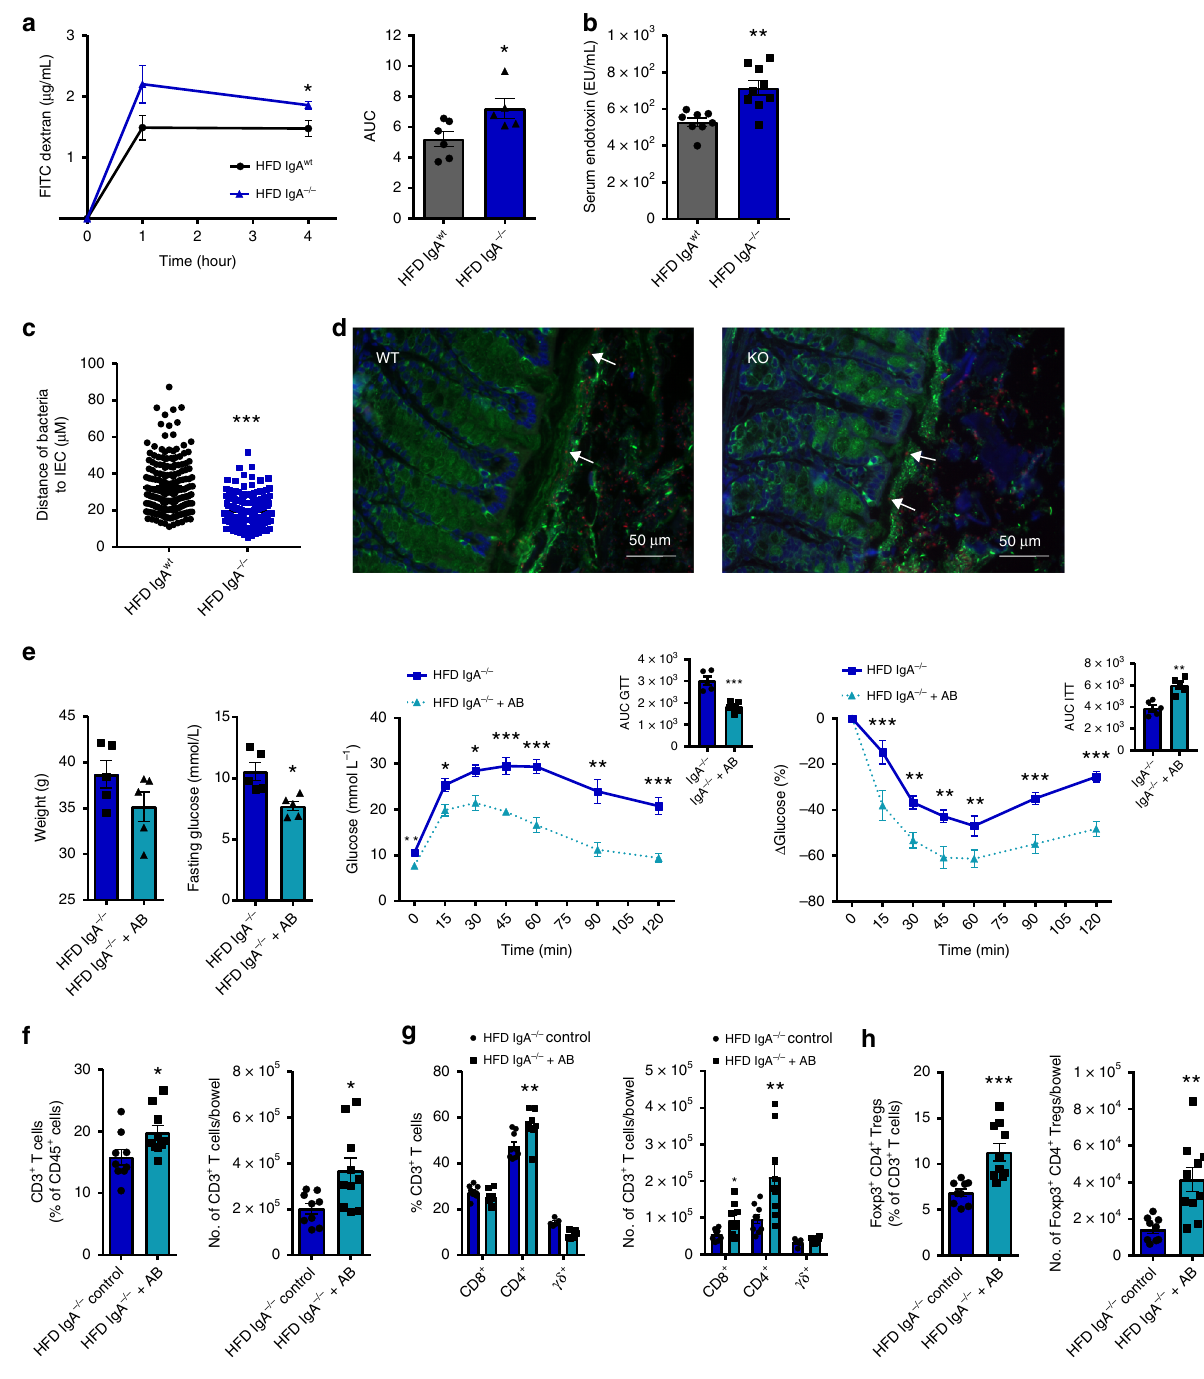
Fig. 6 Altered glucose metabolism in high fat diet (HFD)-fed immunoglobulin A (IgA)-de fi cient mice is linked to host – microbe interactions. a Intestinal permeability assay measuring concentration of fl uorescein isothiocyanate (FITC)-labelled-dextran by fl uorescence (left) and represented by area under the curve (AUC) (right) in collected plasma 1 and 4 h post gavage in HFD-fed wild-type (WT) and IgA − / − mice ( n = 6 WT, 5 IgA − / − mice). b Serum endotoxin levels in WT and IgA − / − mice fed HFD for 14 weeks ( n = 8 WT, 9 IgA − / − mice). c Distance of bacteria from intestinal epithelial cells (IECs) in HFD-fed WT and IgA − / − mice ( n = 4/group). d Representative images of fl uorescence in situ hybridization (FISH) and immuno fl uorescence staining of the bacteria (red), mucous layer (green), and intestinal cells (4 ′ ,6-diamidino-2-phenylindole (DAPI)-blue) of colon (scale bar = 50 µ m; white arrows indicate representative encroaching bacteria to intestinal epithelium). e Weights (left), fasting glucose levels (left middle), blood glucose concentrations with AUCs during glucose tolerance (GTT) (right middle) and insulin tolerance test (ITT) (right) in HFD-fed IgA − / − mice treated with antibiotics in drinking water for 4 weeks compared to HFD-fed IgA − / − untreated controls ( n = 5 mice/group). Frequency (left) and absolute number (right) of f CD3 + T cells, g T cell subsets, and h Foxp3 + CD4 + Tregs within the colonic lamina propria (LP) in IgA − / − mice treated with antibiotics in drinking water for 4 weeks compared to IgA − / − untreated controls fed HFD for total of 14 weeks ( n = 9 WT, 10 IgA − / − mice, 2 experiments). Data are means± SEM. * denotes p < 0.05, ** denotes p < 0.01, and *** denotes p <